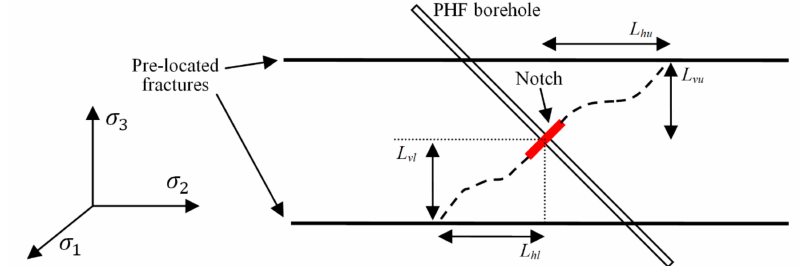
Figure 2. Dependent factors considered in prescribed hydraulic fracturing [32]: the four factors L vu , L hu , L vl , and L hl quantify and measure the PHF